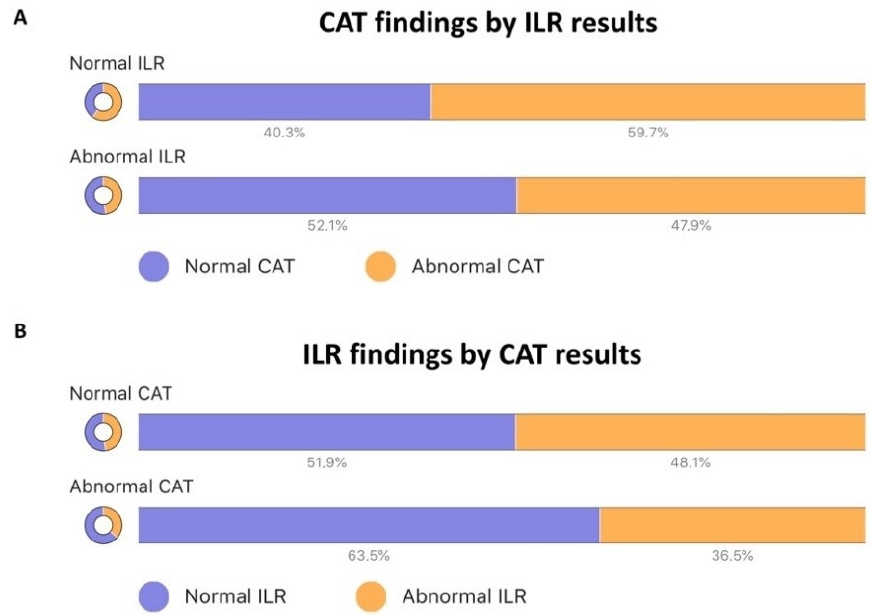
Figure 2. Distribution of normal and abnormal ILR and CAT findings in patients with unexplained syncope. Panel ( A ): CAT findings by ILR results. Panel ( B ): ILR findings by CAT results. CAT, cardiovascular autonomic testing; ILR, implanted loop recorder.